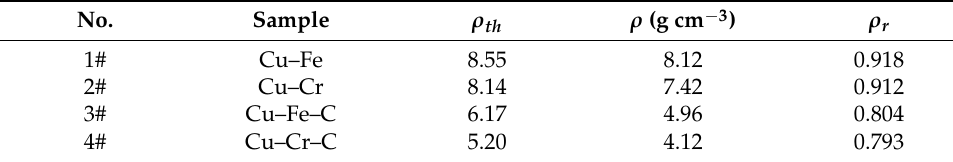
Table 3. Relative density and density of